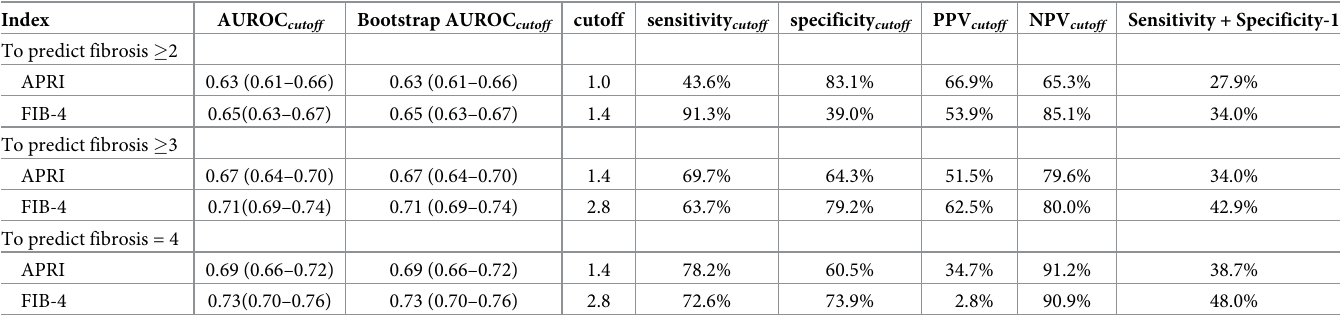
Table 7. Diagnostic accuracies of APRI and FIB-4 for predicting liver fibrosis (Minimal-mild necroinflammation score 1–8, N = 1171). Index AUROC cutoff